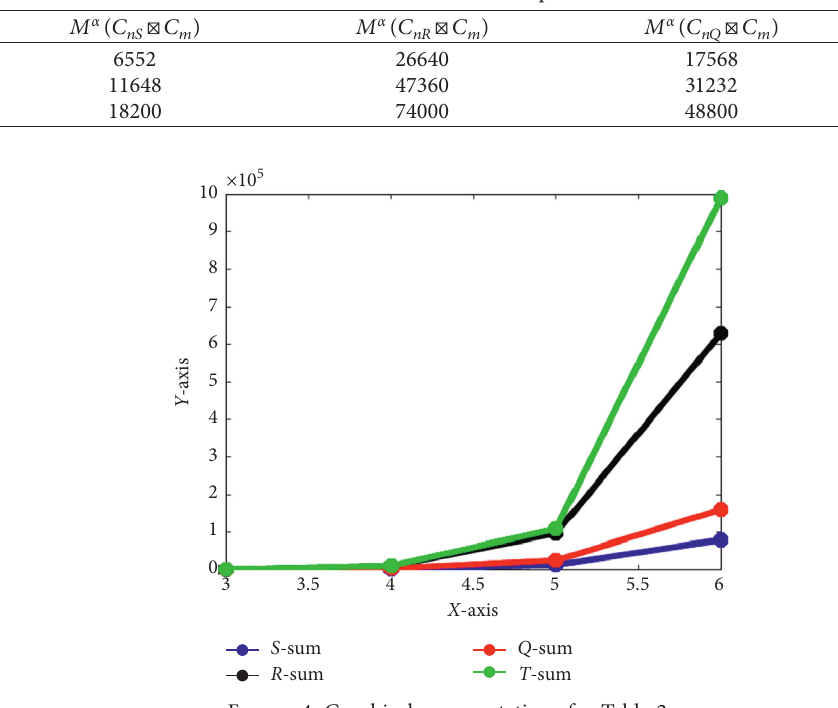
Figure 3: Graphical representations for Table 1. Table 2: Table for Example 2.